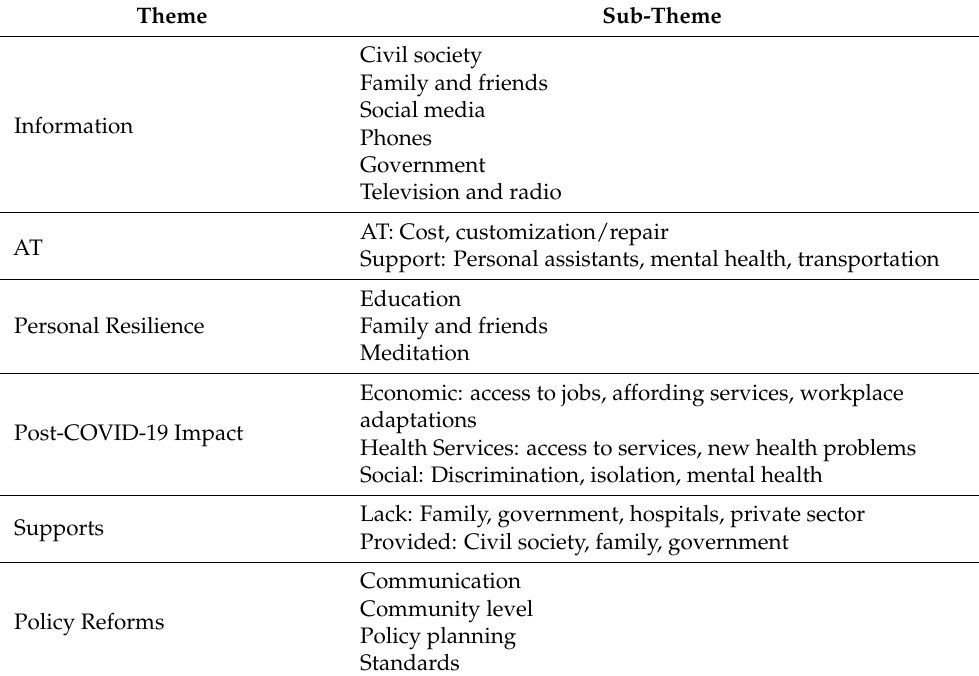
Table 1. Overview of themes and sub-themes